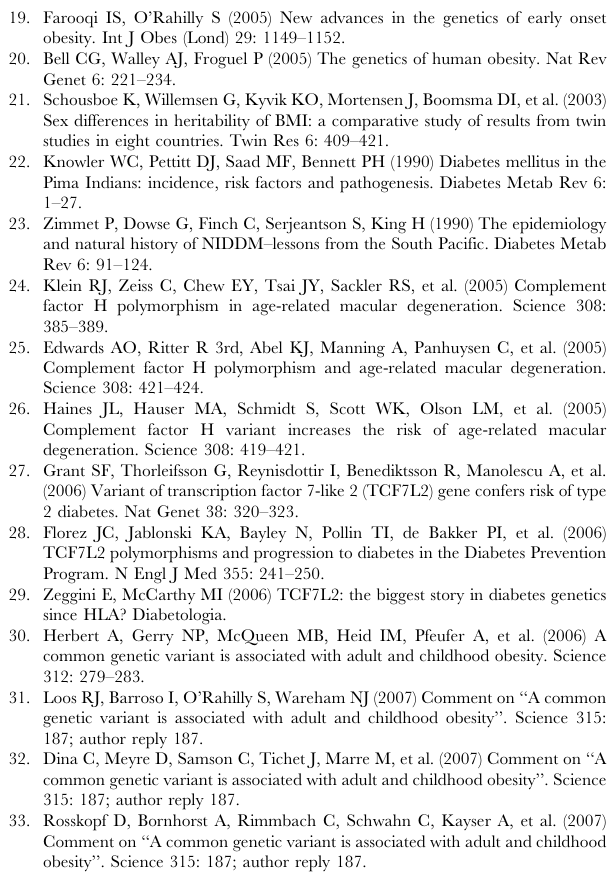
Figure S2 FTO region of LD in the relevant cohorts from the HapMap project